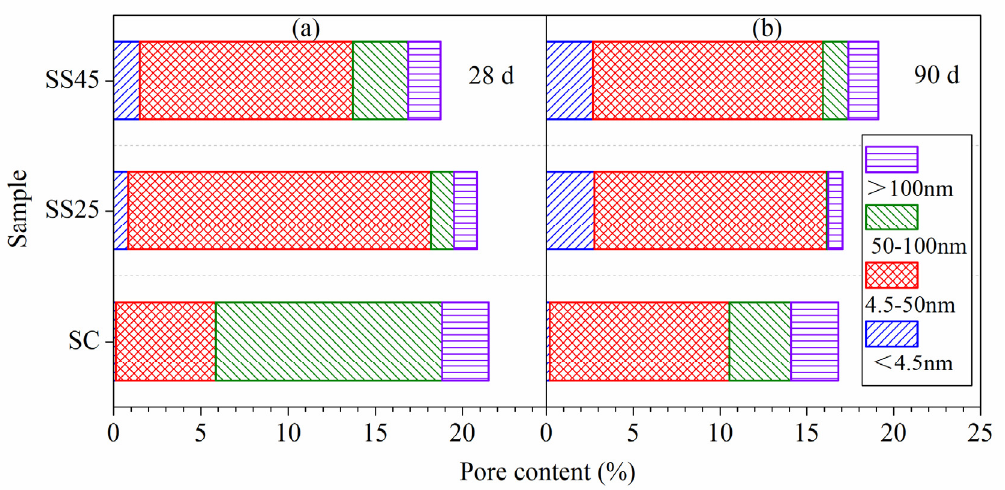
Figure 7. The pore size distribution of hardened pastes under standard curing conditions: ( a ) at 28 d; ( b ) at 90 d.